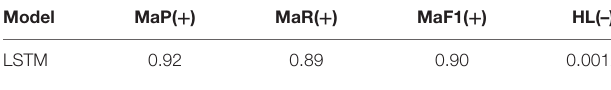
TABLE 4 | The performance of multi-label classification